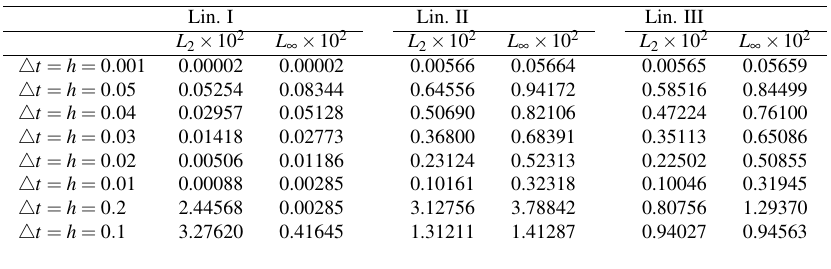
Table 1 Comparison of the error norms L 2 and L ∞ that are obtained using the linearization techniques at t = 1 , α = 0 . 9 for different values of ∆ t , h